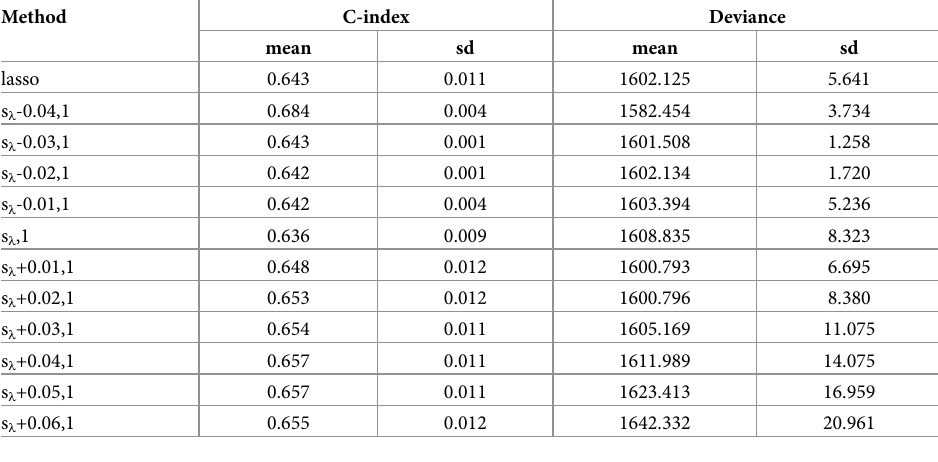
Table 2. Outcome of 10 times 10-fold cross-validation.